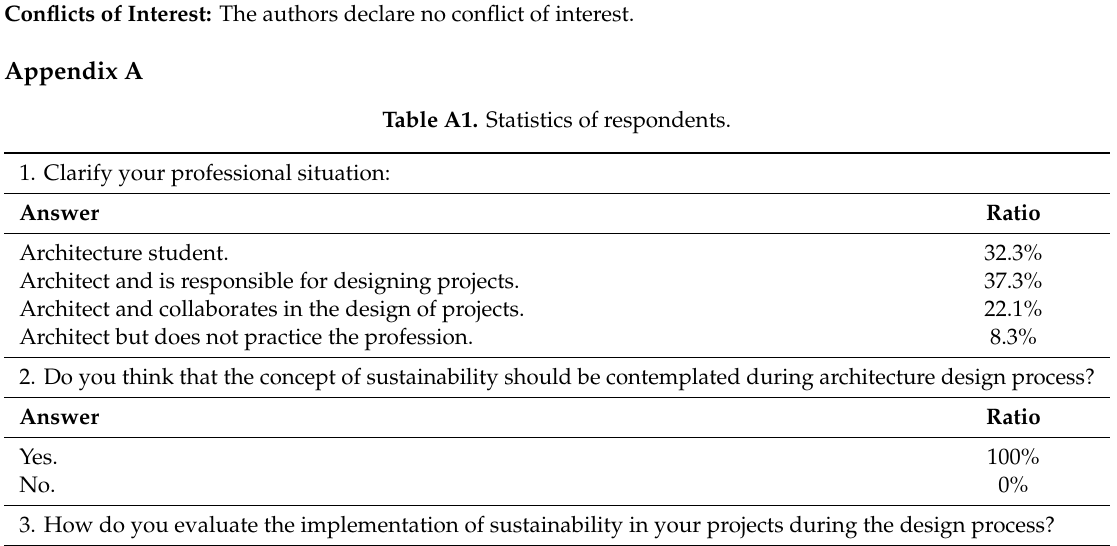
Table S1: PROGRAM AND DATA COLLECTION; Table S2: FEASIBILITY STUDY; Table S3: PRELIMINARY DESIGN, Table S4: DETAIL DESIGN.